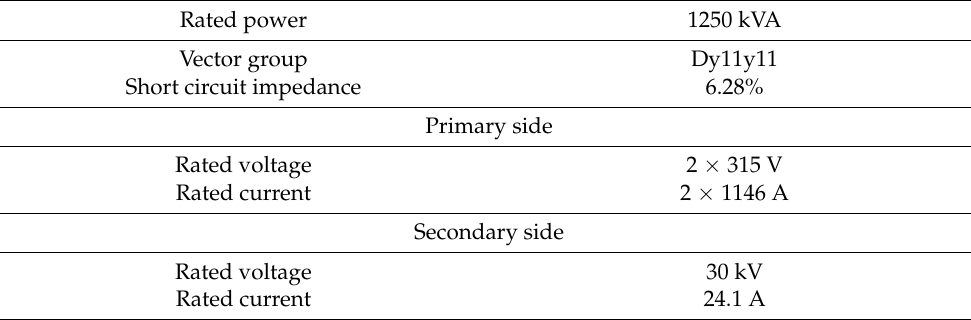
Table 15. Technical data of SCLB10 transformer [89].